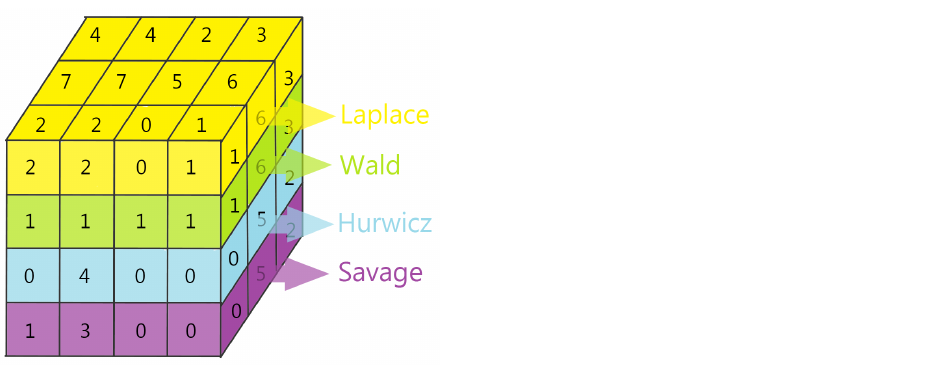
Figure 2. The compact form of the 3D matrix A ∈ R 4 × 4 × 3 of Example 1 and the suggested solutions with 3D decision